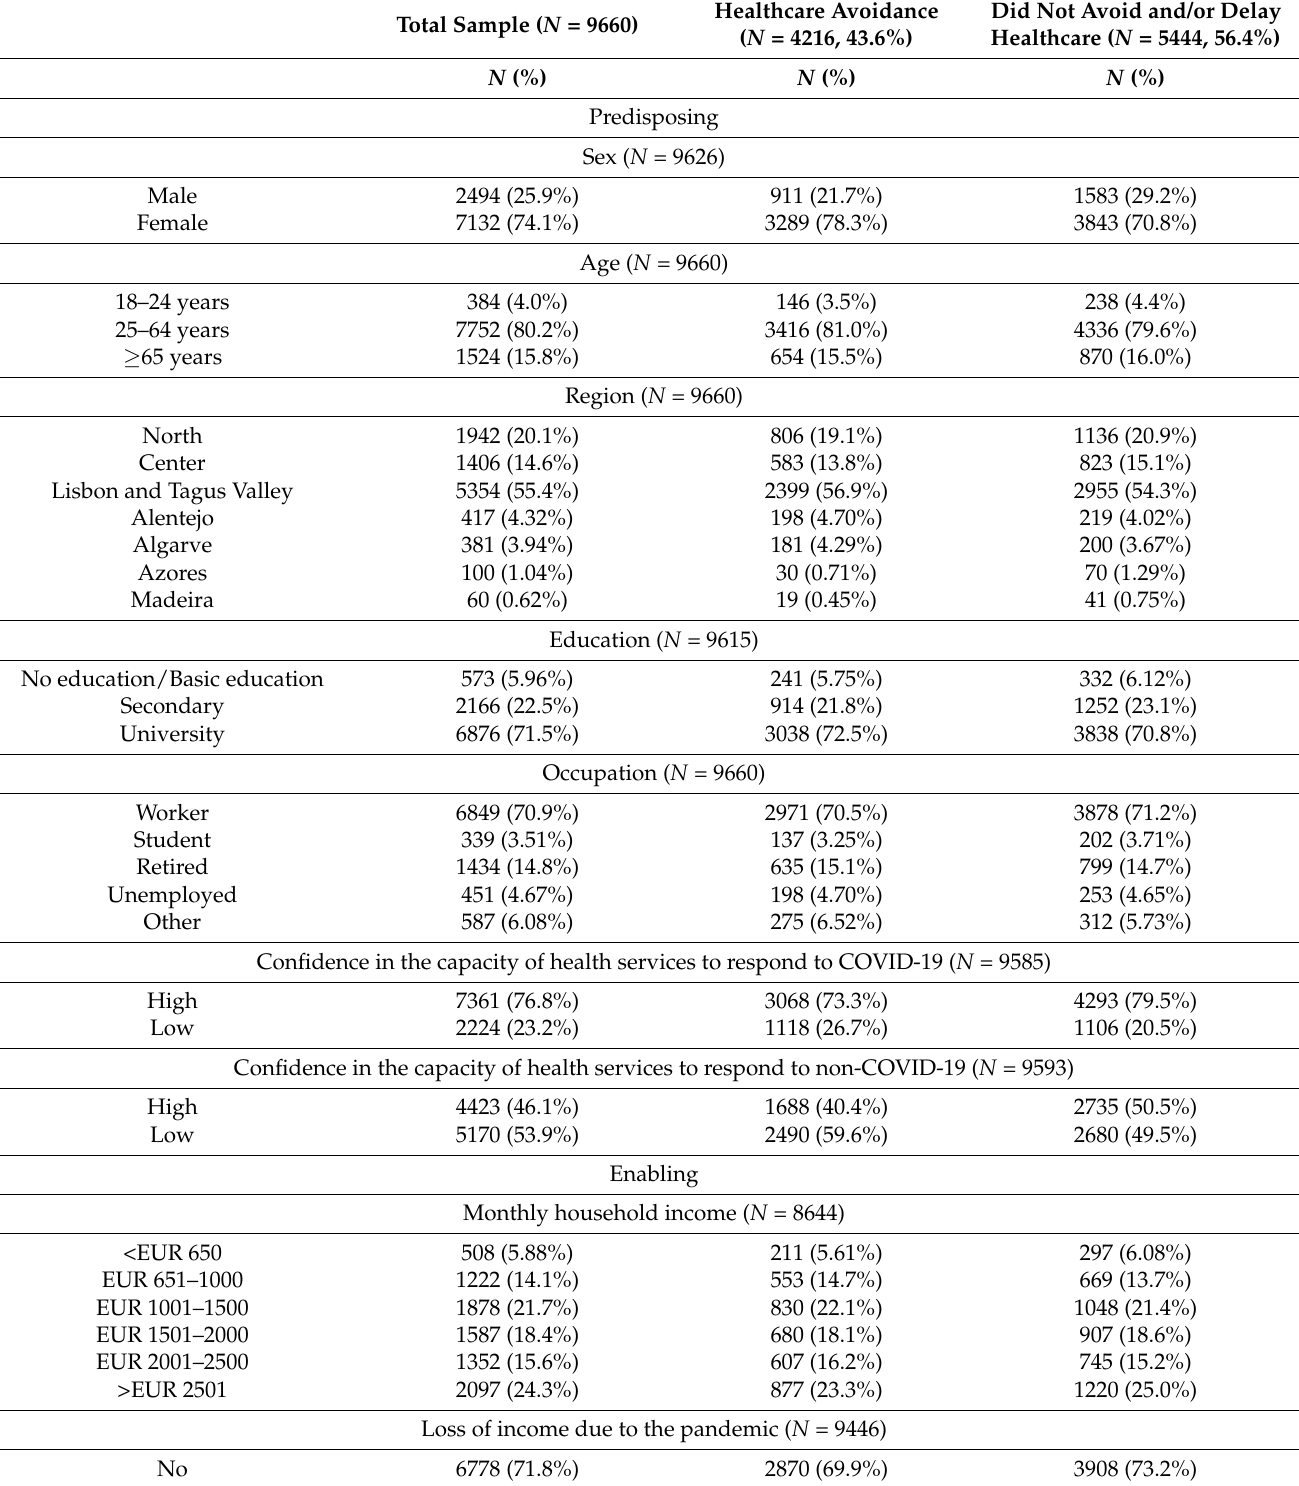
Table 2. Sample characteristics according to predisposing, enabling, need for care and COVID-19-specific